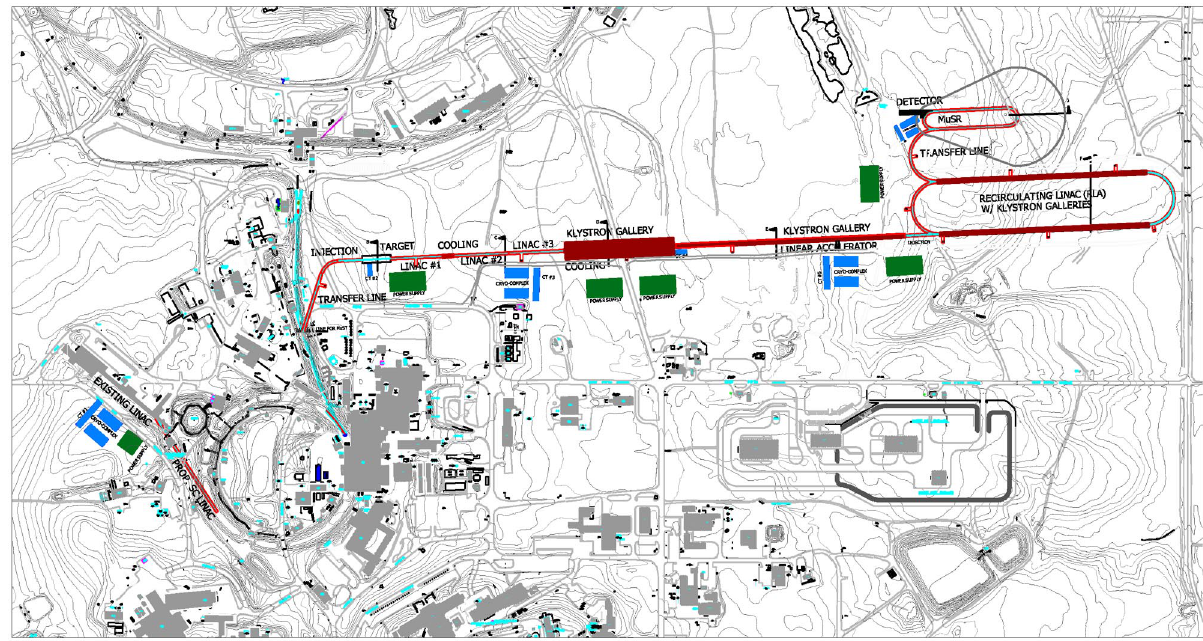
FIG. 27. (Color) Schematic of a 20 GeV neutrino factory at BNL.